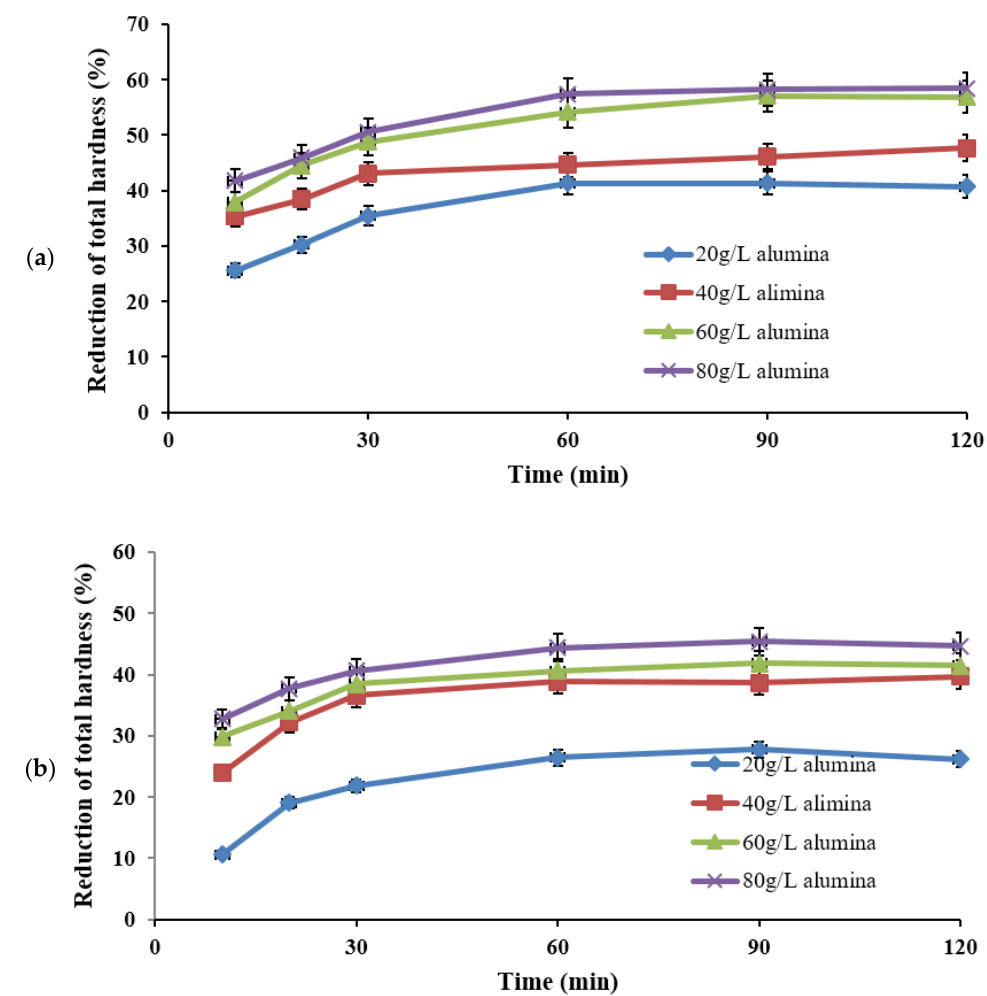
Figure 11. The effect of different concentrations of activated alumina (g/L) on reducing total hardness (%) of ( a ) drinking water and ( b ) groundwater.